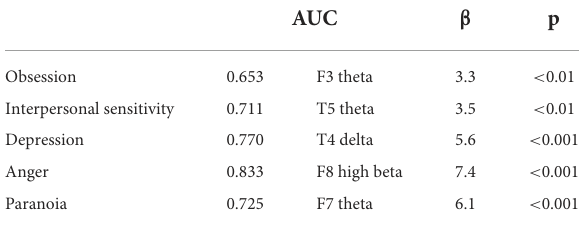
TABLE 3 Regression of correlations between QEEG spectral power density and psychiatric symptomatology (Scl-90-R) in affective